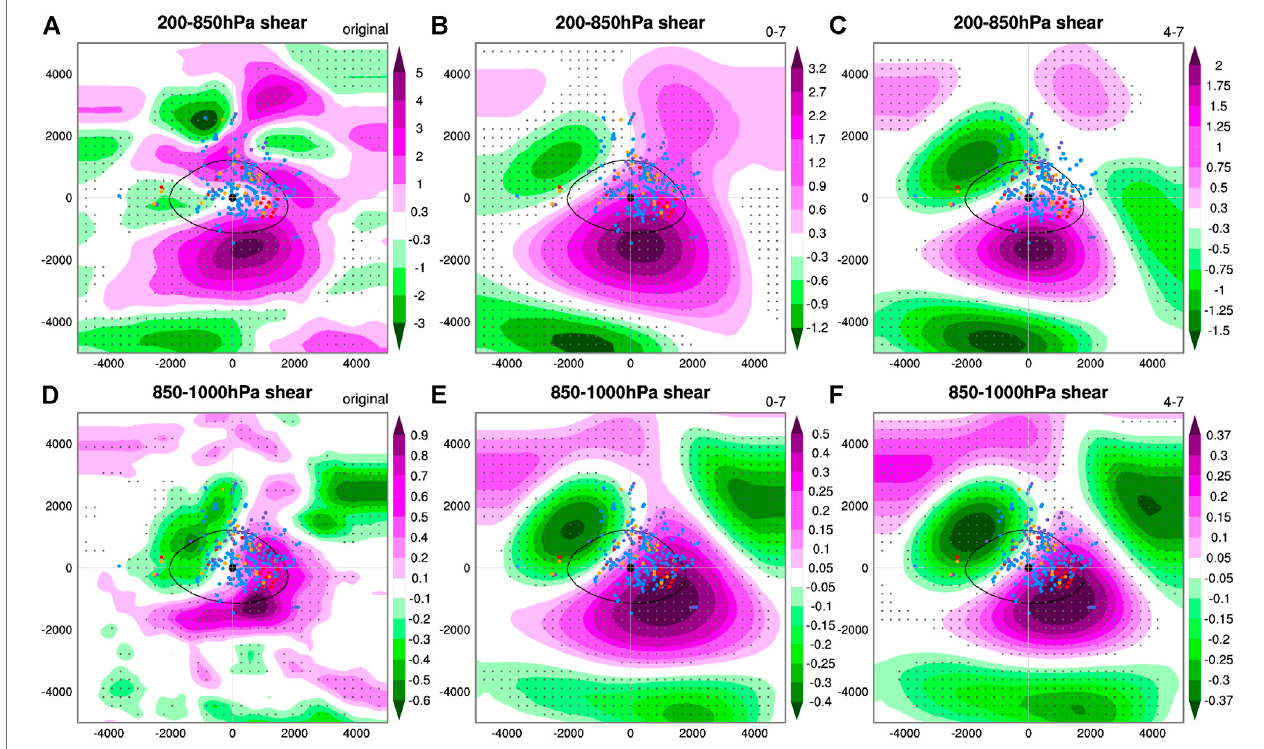
FIGURE 10 | (A – C) Composite deep (200 – 850 hPa) VWS anomalies (m s − 1 , shadings) relative to the daily climatology centered on the composite MG, and (D – F) composite shallow (850 – 1,000 hPa) VWS anomalies (m s − 1 , shadings) relative to the daily climatology centered on the composite MG (A) and (D) VWS without fi ltering (B) and (E) VWS with wavenumbers 0 – 7 (C) and (F) VWS with wavenumbers 4 – 7. The origin (0,0) is the position of the MG center, the black contour represents the MG center and the small dots indicate the locations of RW events of TCs. The black crosses represent the area that exceeds the statistical Student ’ s t test at the 0.05 signi fi cance